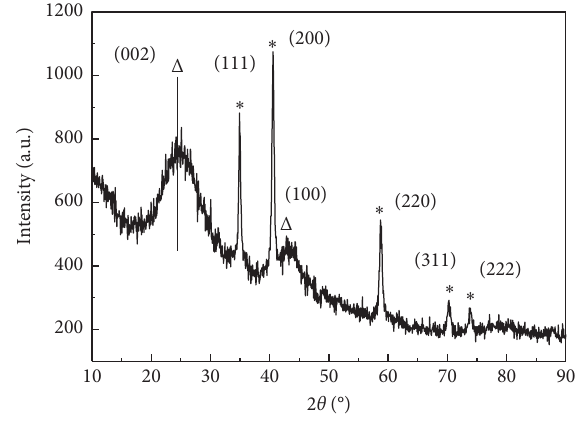
Figure 5: XRD patterns of 10 wt. %